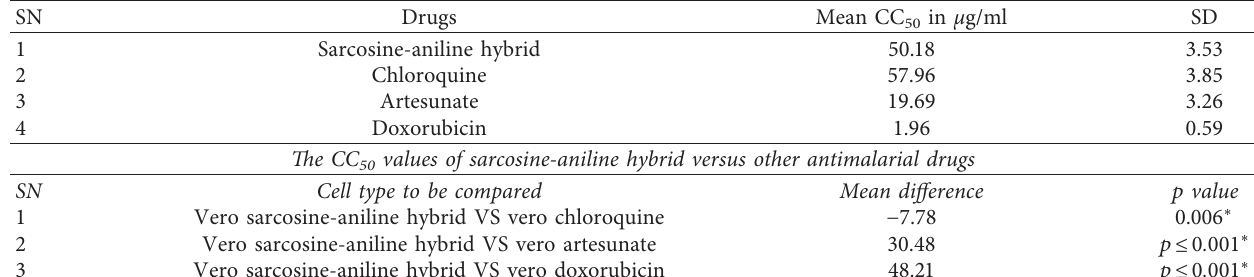
Table 6: The CC 50 values of the different antimalarial drugs against vero